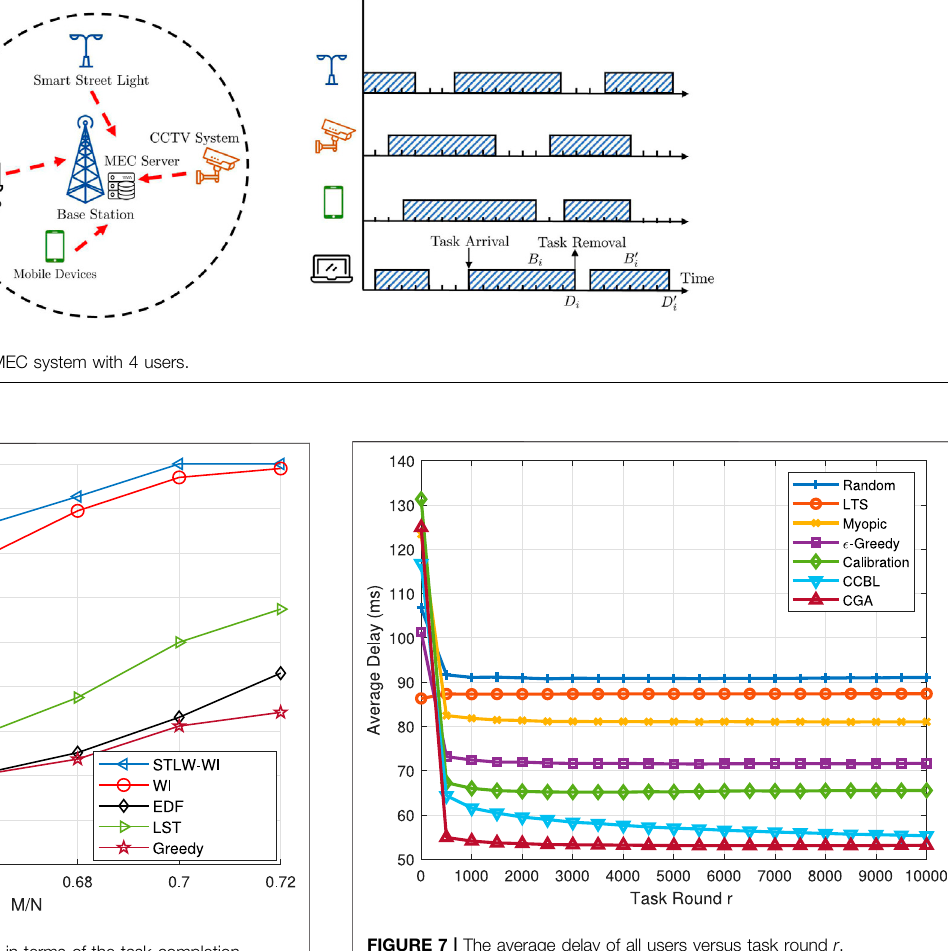
FIGURE 5 | Performance comparison in terms of the task completion ratio.